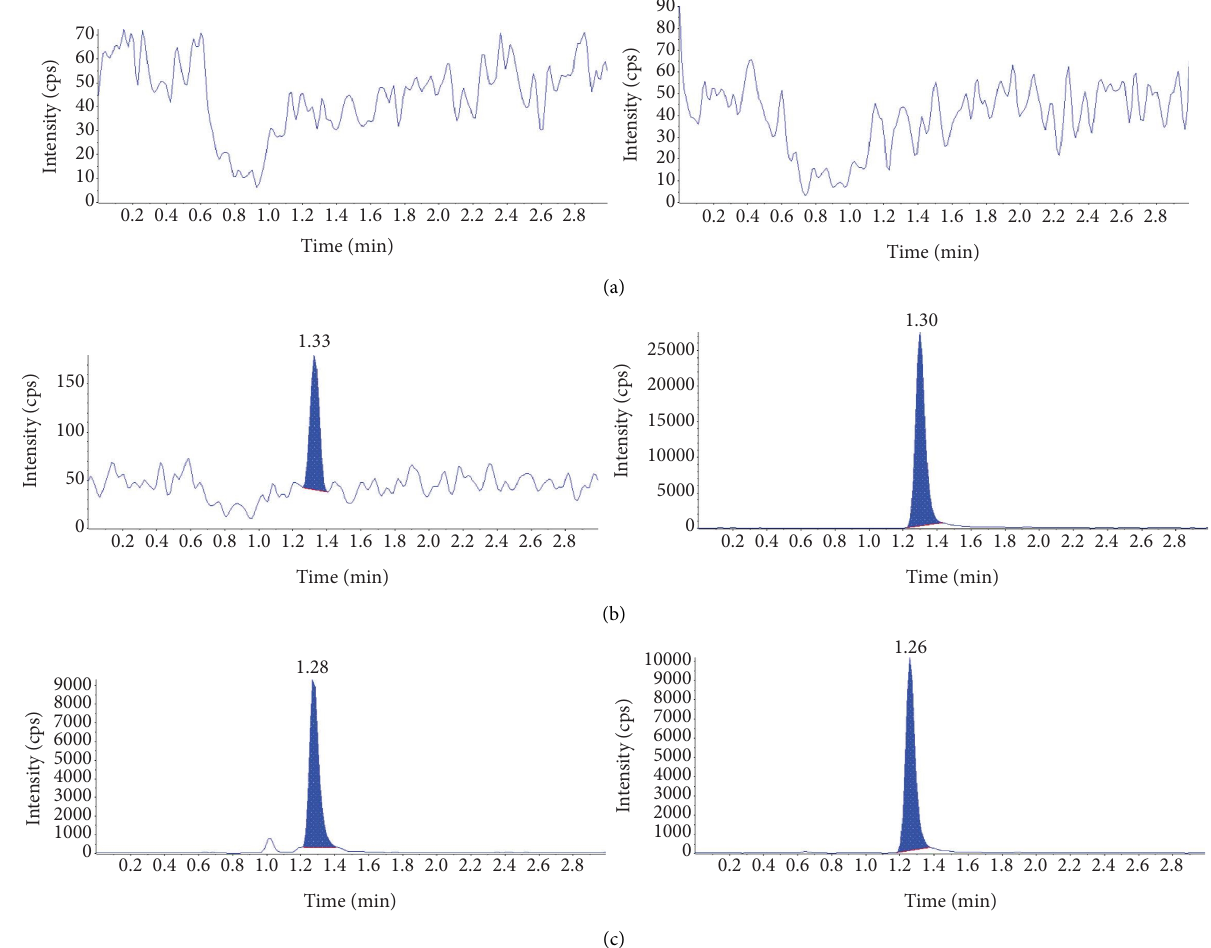
Figure 3: Representative chromatograms of gemifoxacin in (a) blank plasma; (b) blank plasma spiked with gemifoxacin at the lower limit of quantitation; and (c) plasma obtained from a participant at 0.67h after the administration of a single oral dose of 320mg gemifoxacin. Left panel: gemifoxacin; right panel: moxifoxacin (internal standard). Table 1: Accuracy and precision values of the proposed method for determining gemifoxacin levels in human plasma samples ( n � 3). Concentration ( μ g/mL) % intraday accuracy Intraday precision (% CV) % interday accuracy Interday precision (% CV)